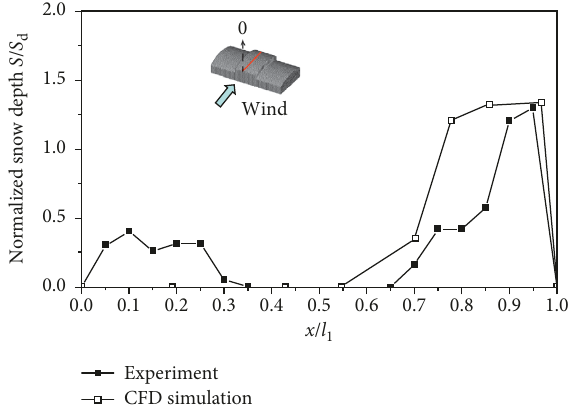
Figure 16: Comparison of results by means of experiments and CFD simulation along the central line when wind direction